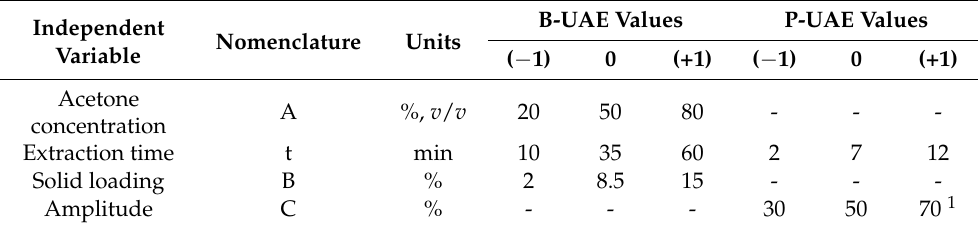
Table 1. Uncoded and coded values of the factors studied by a Box–Behnken design and a